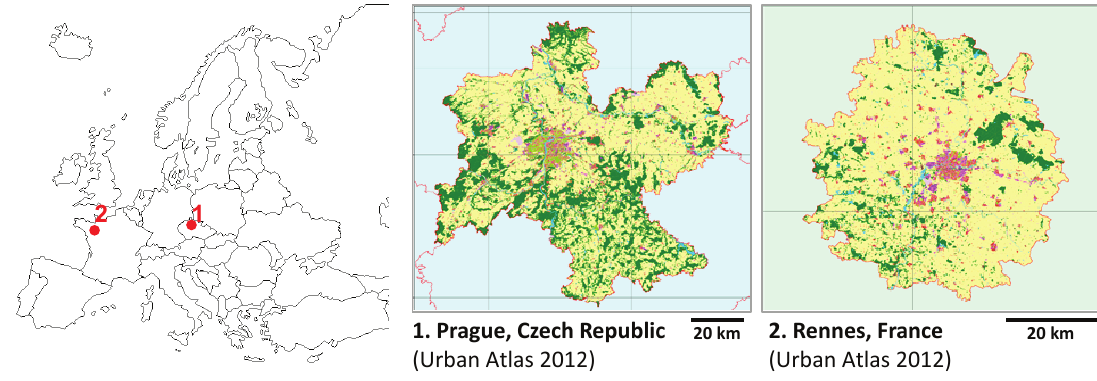
Figure 1. Presentation of the study areas.